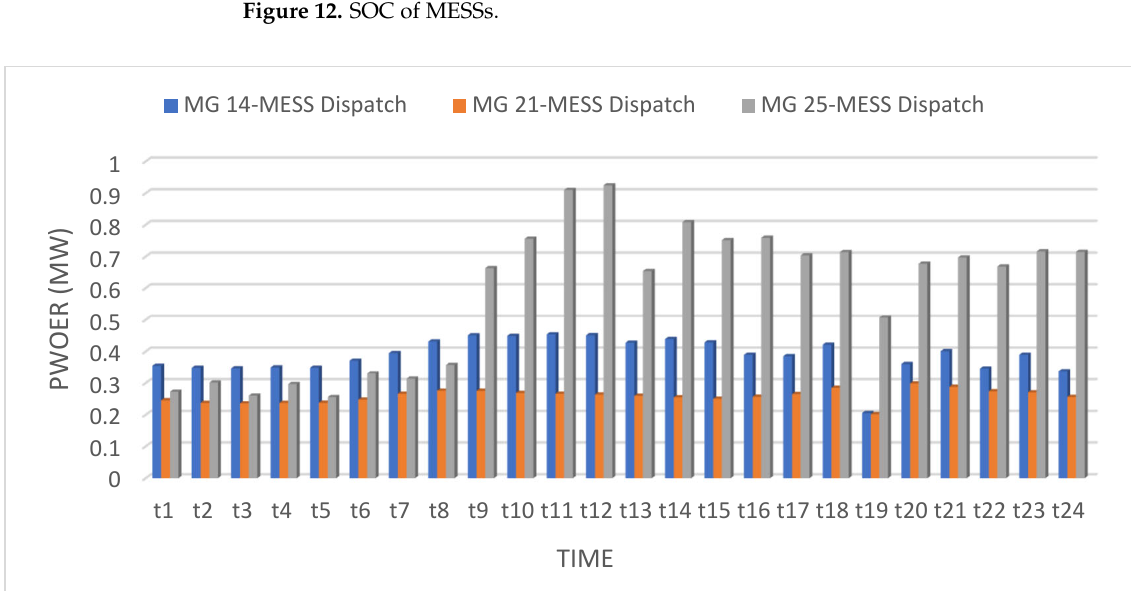
Figure 12. SOC of MESSs.